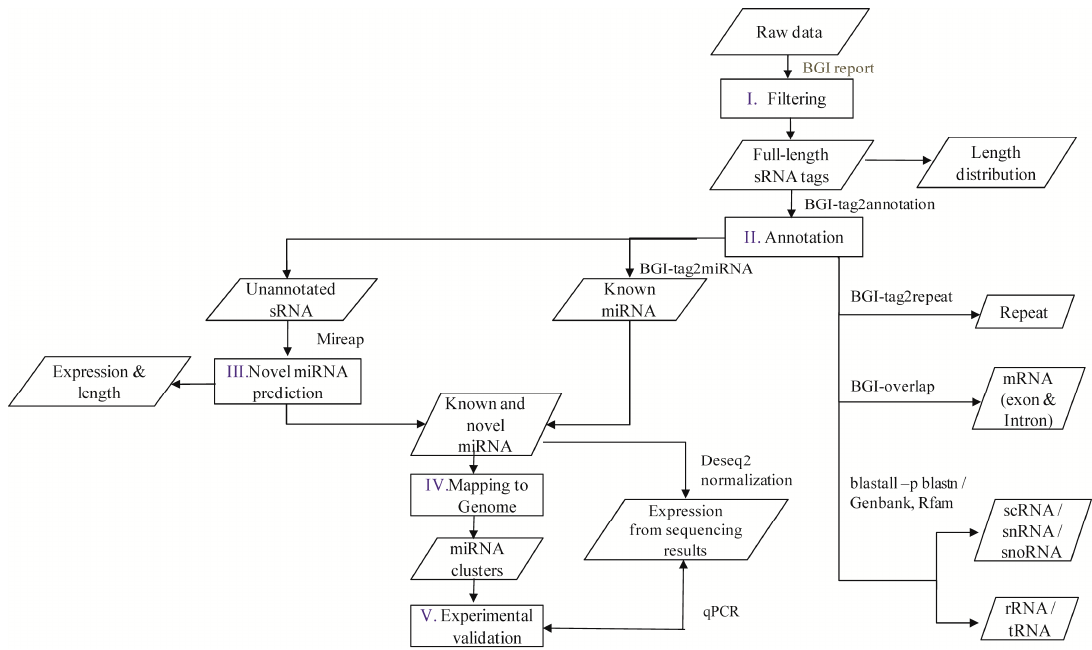
Figure 1. Flowchart of the miRNA analysis performed in the present study. The encircled numerals (I to V) indicate the order in which the experiments were carried out. The sequencing data from an Ilumina sequencer was used as raw data, which were further cleaned and annotated to segregate as well as identify different types of sRNAs. Known miRNAs were identified using miRBase and identification of novel miRNAs was carried out using MIREAP software, results from both of which were then analyzed to study families, clusters, and the validation of their expression.